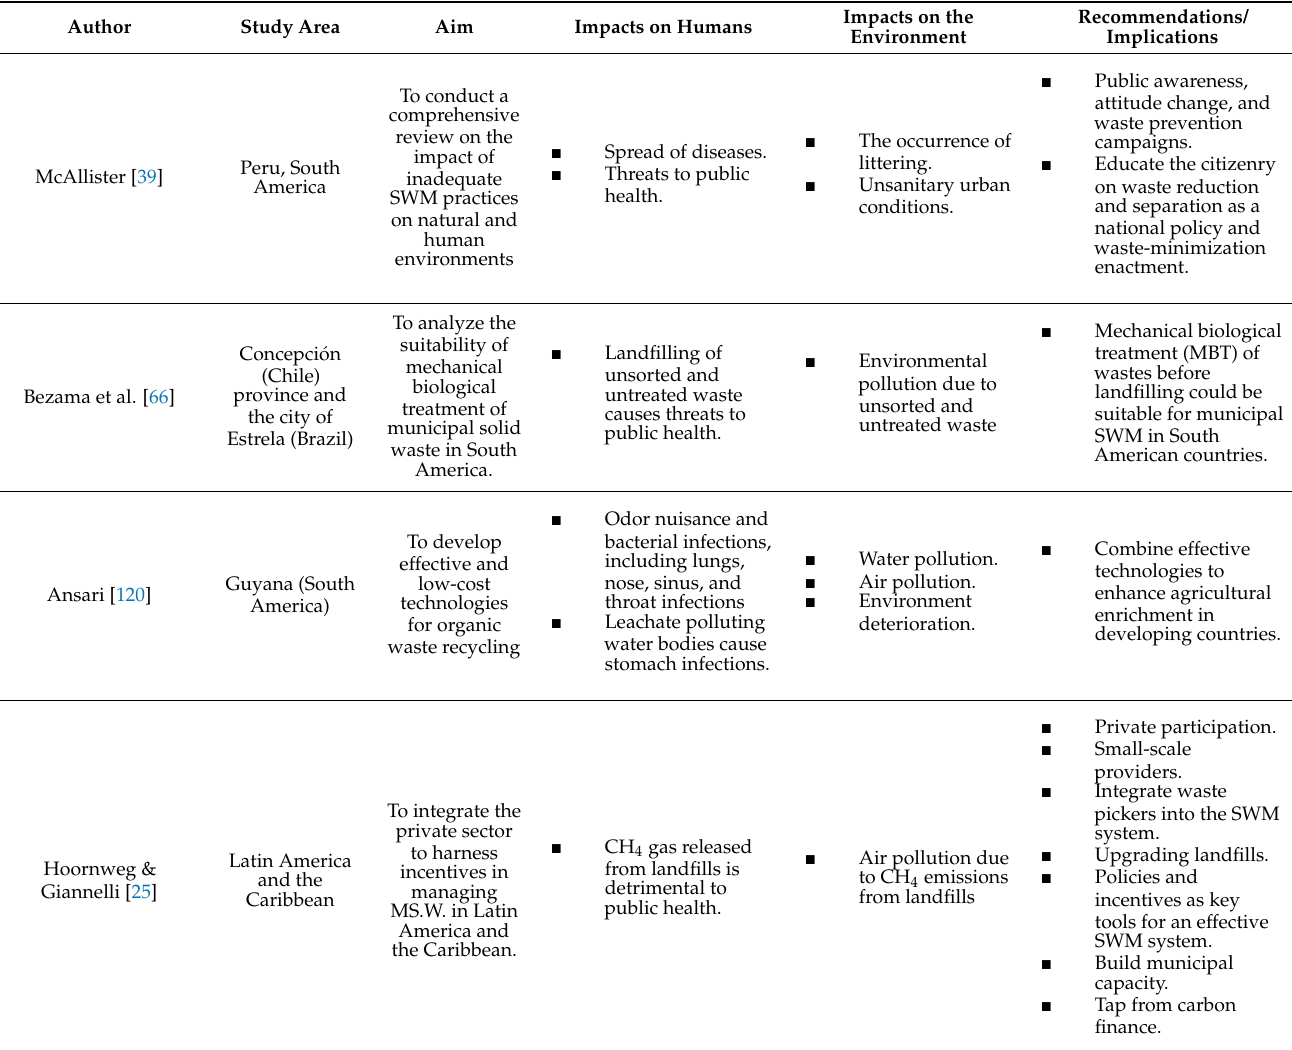
Table A2. Reviewed literature on the impacts of SWM practices in South America (compiled by